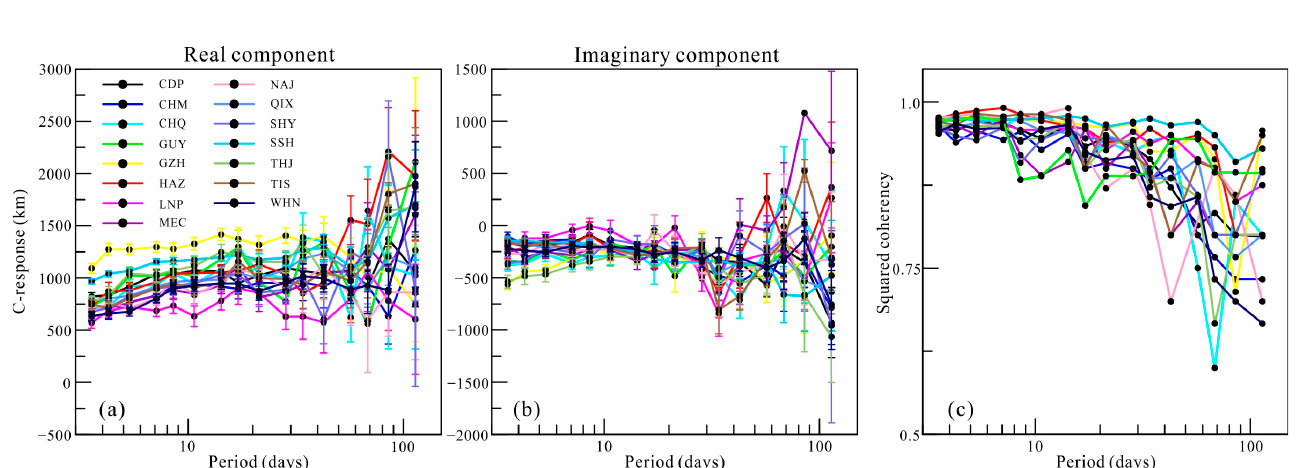
Figure 2. C-responses and their squared coherency at the 15 selected observatories. The lines in ( a , b ) are the real and imaginary components of the C-responses, and vertical lines are the data errors. ( c ) The variations in the squared coherency of